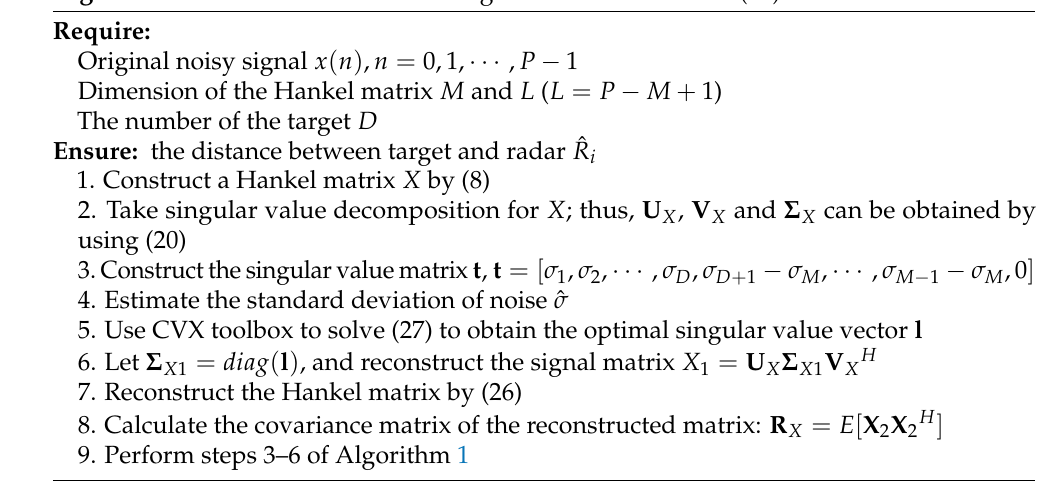
Algorithm 2 Enhanced Root-MUSIC algorithm via solution of (27)